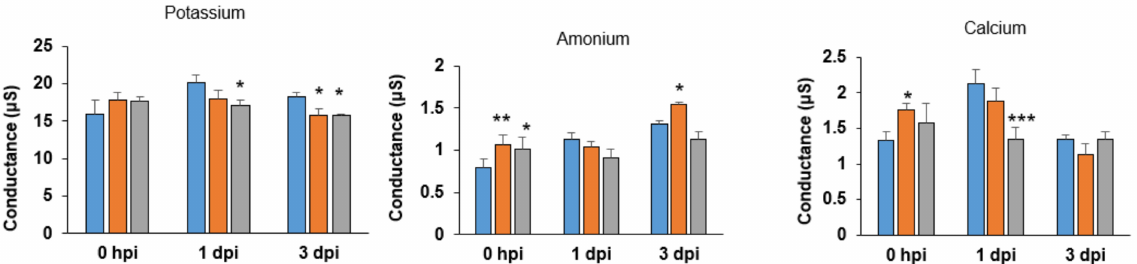
Figure 6. Nutrient accumulation between the AtNFS1 overexpressor lines and WT plants upon P. syringae pv. tomato DC3000 infection: The aerial part (leaf and stem) of 5-week-old Arabidopsis seedlings was collected from four plants ( n = 4) between the WT and AtNFS1 overexpression lines NFS1.2-18-OX and NFS1.2-7-OX at different time points (0 hpi, 1 dpi, and 3 dpi) upon flood-inoculation with host pathogen P. syringae pv. tomato DC3000 (8 × 10 4 CFU/mL). Metabolites from these samples were extracted and levels of several essential nutrients (cations and anions) were monitored by ion chromatography. Histograms represent means of four biological replicates. Error bars indicate standard error. Asterisks indicate significant differences according to Student’s t test (* p- value < 0.05, ** p- value < 0.01, *** p- value < 0.001). hpi, hours post infection; dpi, days post